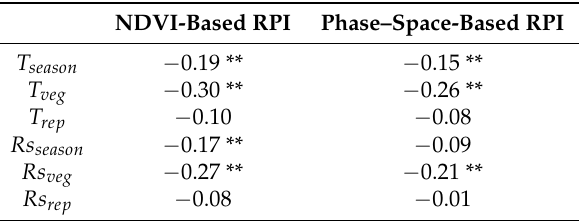
Table 4. Partial correlation coefficients between the relative phenophase index (RPI) and meteorological factors calculated based on the period of the corresponding phenometrics for all pixels in the four experimental sites during the period 2013–2017. ** p -value statistically significant at